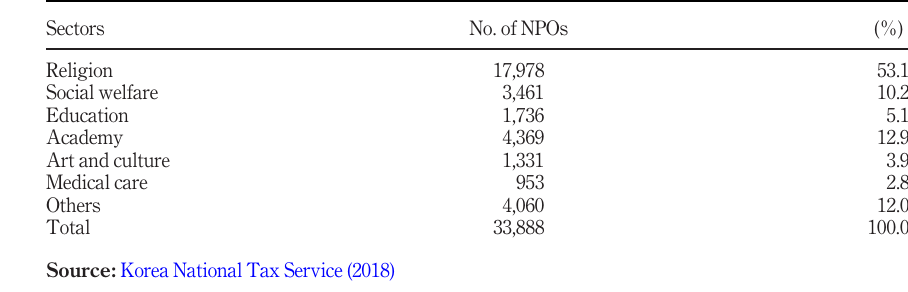
Table I. Current status of Korean NPOs